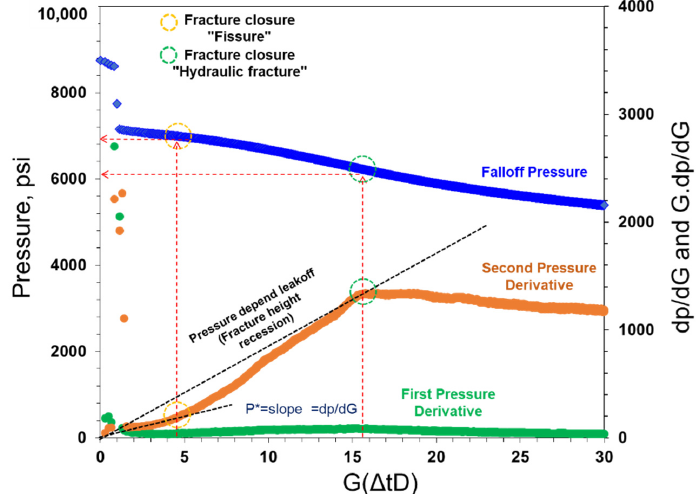
Figure 10. DFIT analysis and G-function plots for W2.